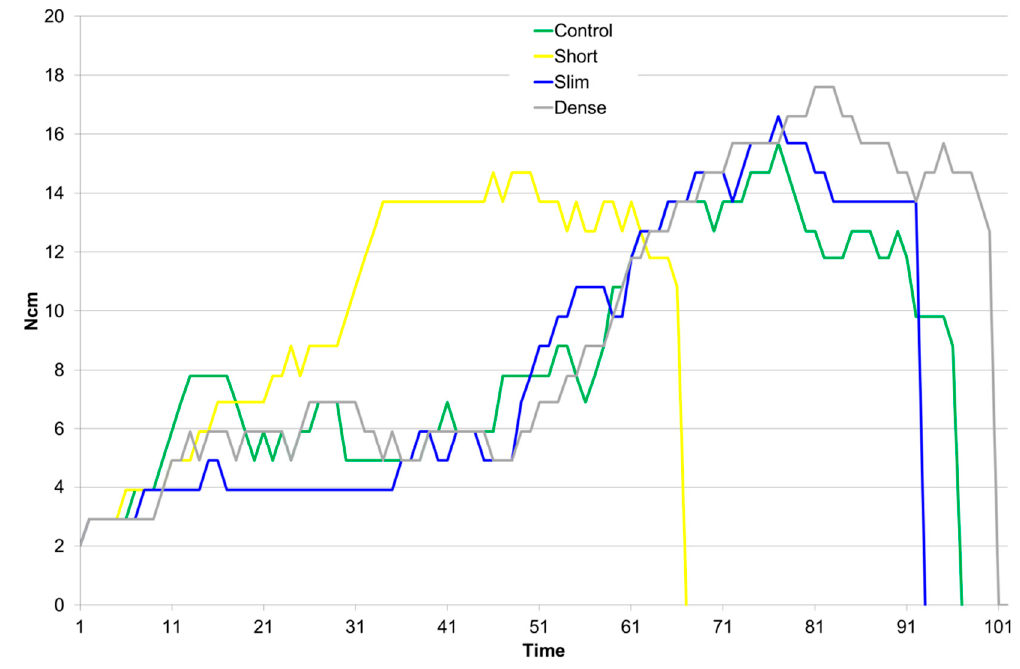
Figure 3. Overview of characteristic torque–time curves determined for the different implants and surgical protocols. Each curve represents one randomly chosen sample per group. Table 2. Mean values and standard deviations (SD) for all parameters evaluated. Group Control